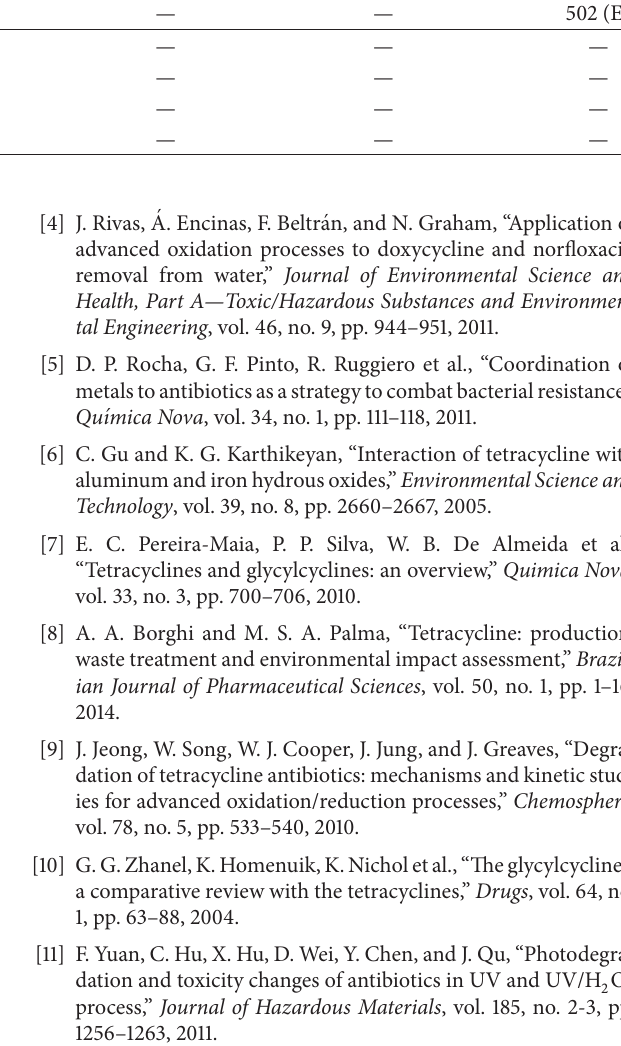
= 25 mg/L, 𝐶 = 611mg/L, and 𝑇 = 35.0 ∘ C). (A) Doxycycline, Fe 2+ H 2 O 2